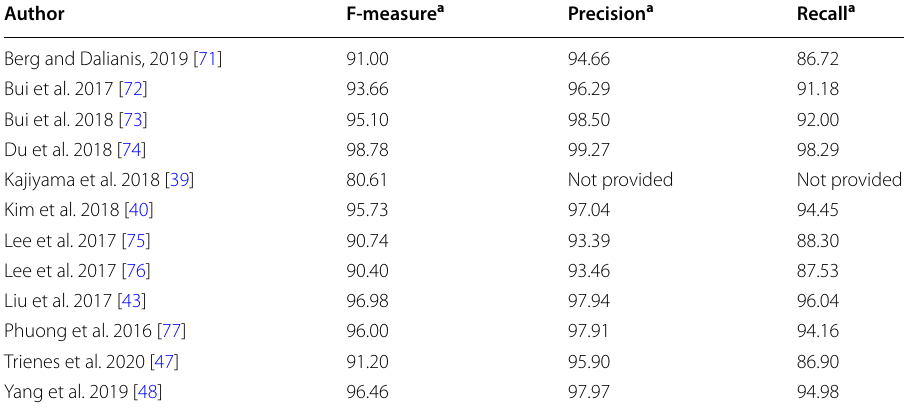
Table 5 CRF papers on de‑identification of medical free text